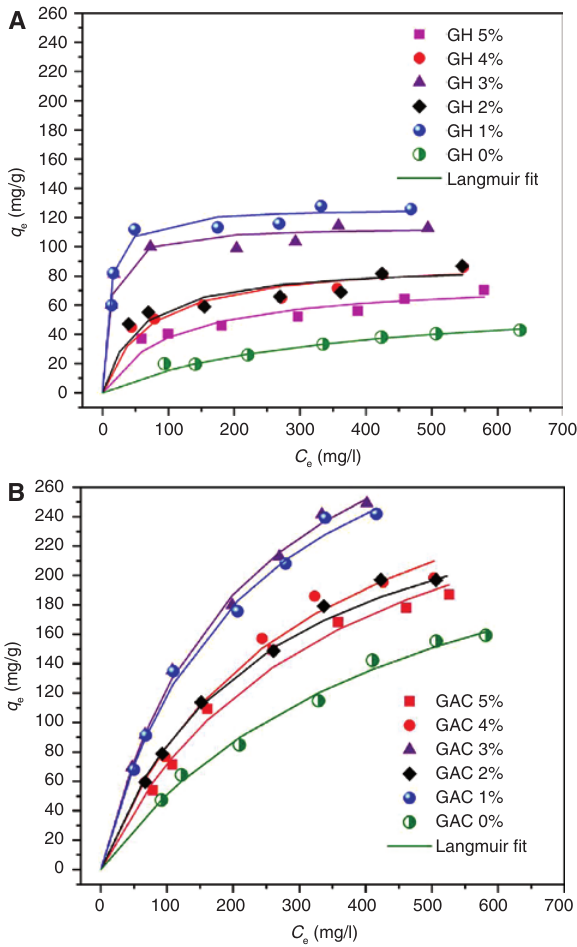
Figure 5: Adsorption isotherms of Pb 2 + ions by various (A) glucose hydrochar and (B) activated carbon (AC)